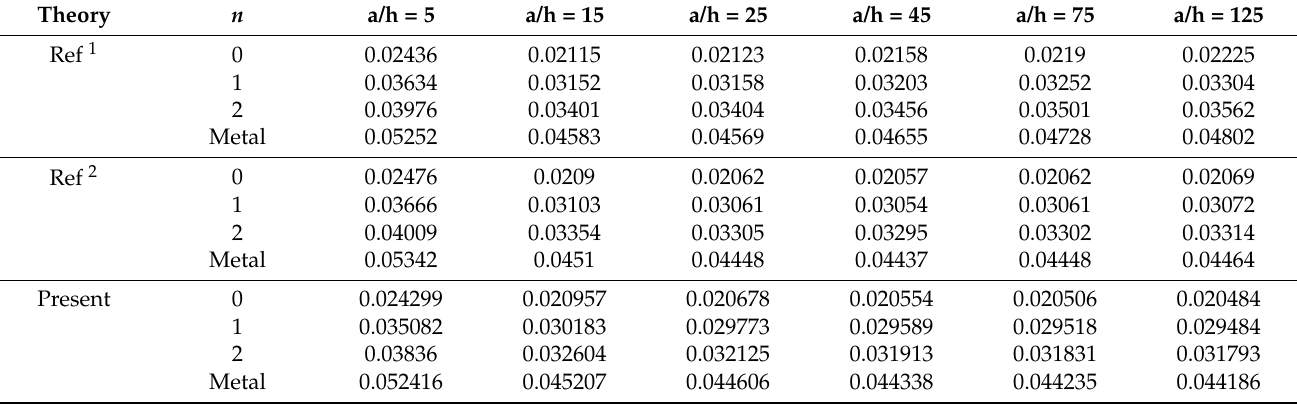
Table 6. Effect of the variation in a/h ratio on the non-dimensional central displacement (w).